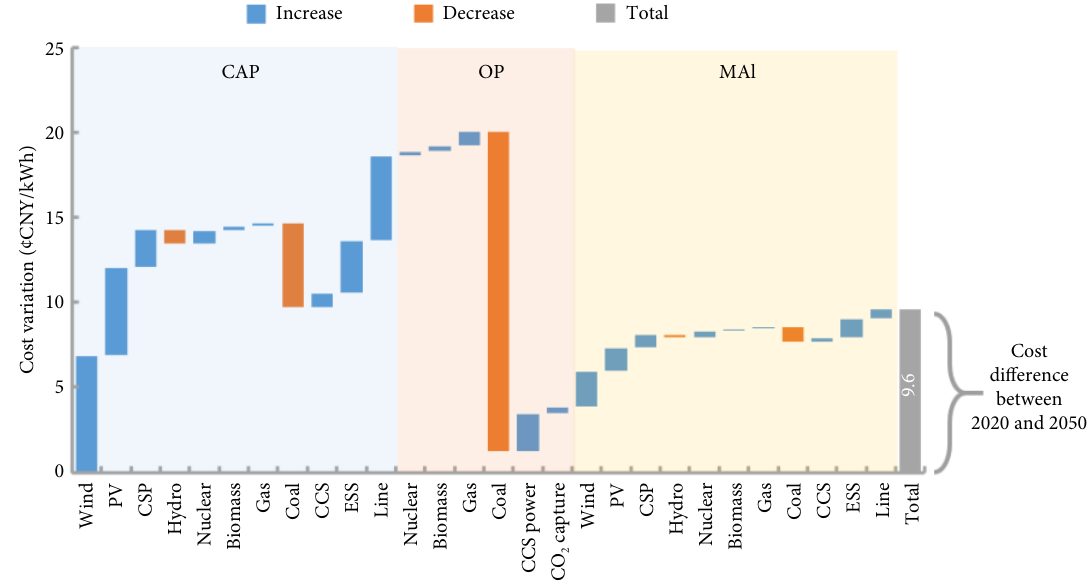
Fig. 2 Composition variation of the electricity supply cost from 2020 to 2050 under the carbon neutrality goals (reprinted with permission from ref. [1], © The Author(s)